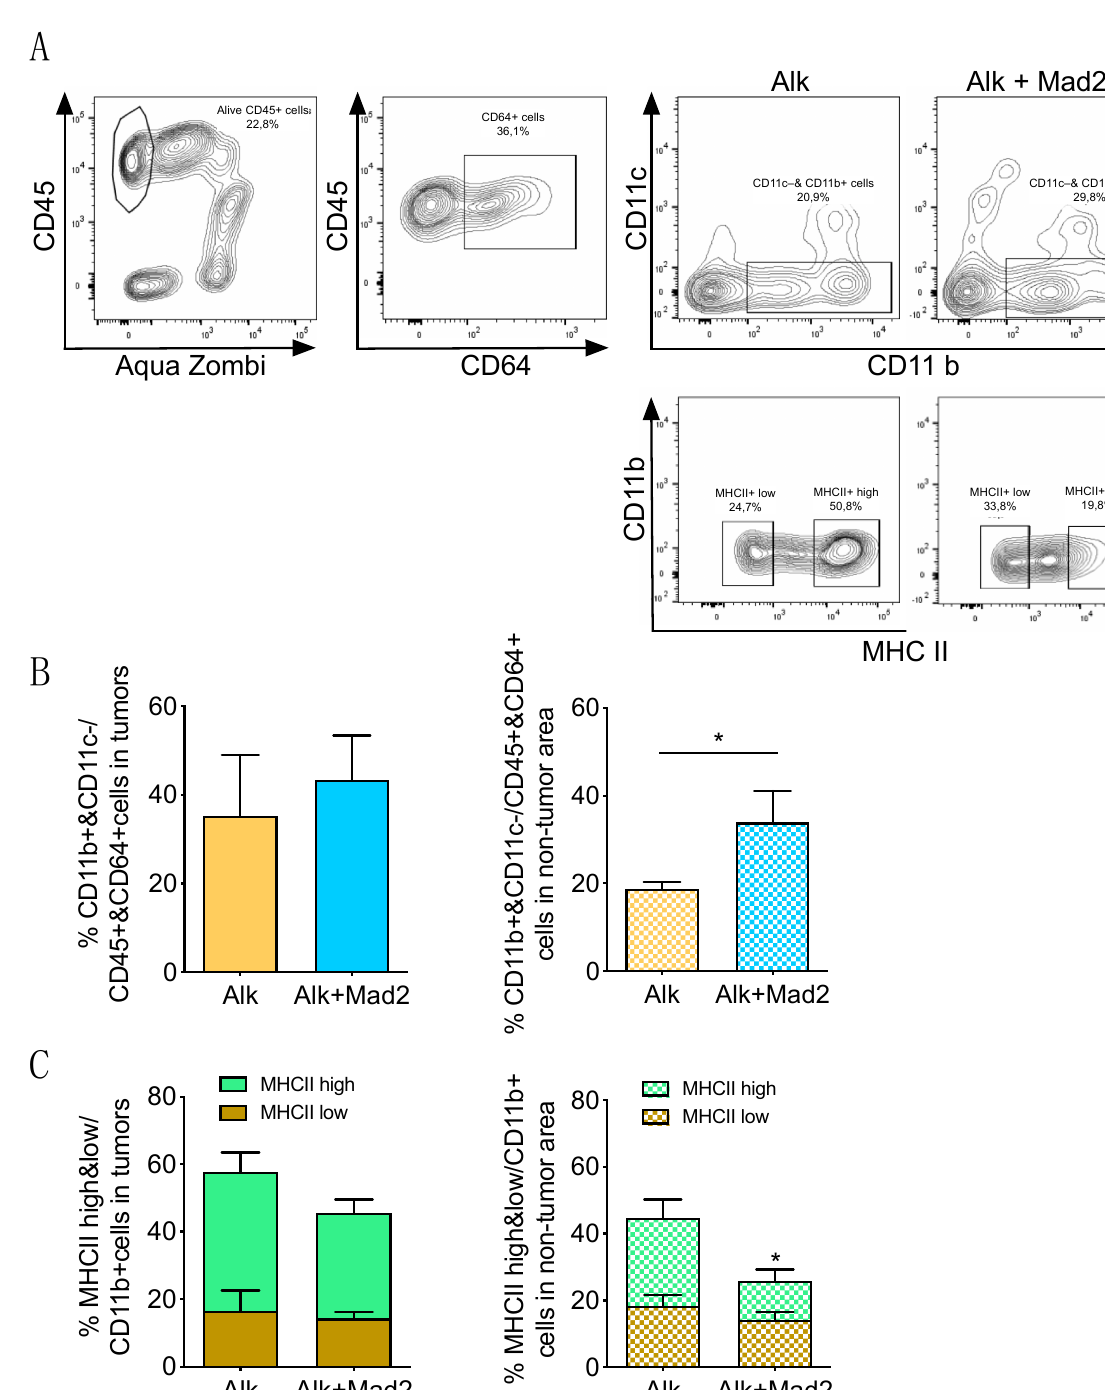
Figure 3. Qualitative characteristics of lung macrophages of Alk and Alk+Mad2 mice ( A ) Lung tumors and non-tumor areas were processed and stained for CD45, CD64, CD11c, and CD11b. Representative flow plots show alive CD45 + cells out of all lymphocytes after exclusion of debris and doublets; CD64 + cells in the alive CD45 + cells; CD11b + interstitial macrophages from the CD64 + CD45 + AquaZombie– cells (up) and MHCII high and MHCII low subpopulation of CD11b + interstitial macrophages (down). ( B ) Percentage of interstitial macrophages gated as CD11b + and CD11c − population from CD45 + and CD64 + population in tumors (Alk; n = 4, Alk+Mad2; n = 7) and in non-tumor area (Alk; n = 10, Alk+Mad2; n = 10). ( C ) Percentage of MHCII high and MHCII low population in CD11b + and CD11c − cells in tumors (Alk; n = 4, Alk+Mad2; n = 7) and non-tumor areas (Alk; n = 10 Alk+Mad2; n = 10). * p < 0.05; Two-tailed t -test.